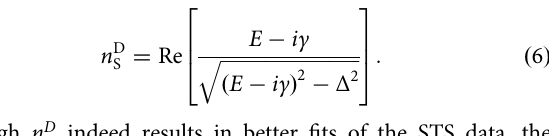
Fig. 5 The environmental P ( E ) function 26 . The P ( E ) function (red line) calculated for the temperature of the environment T env = 1.5 K, environmental impedance R env = 31 Ω , Josephson energy E J = 8 μ eV and junction capacitance C = 100 fF. The black curve displays the model density of states of a Bardeen – Cooper – Schrieffer (BCS) superconductor n BCS ( E ) calculated with the superconducting gap parameter Δ = 173 μ eV. The height of the quasiparticle peaks is limited by the fi nite size of the energy scale used in the